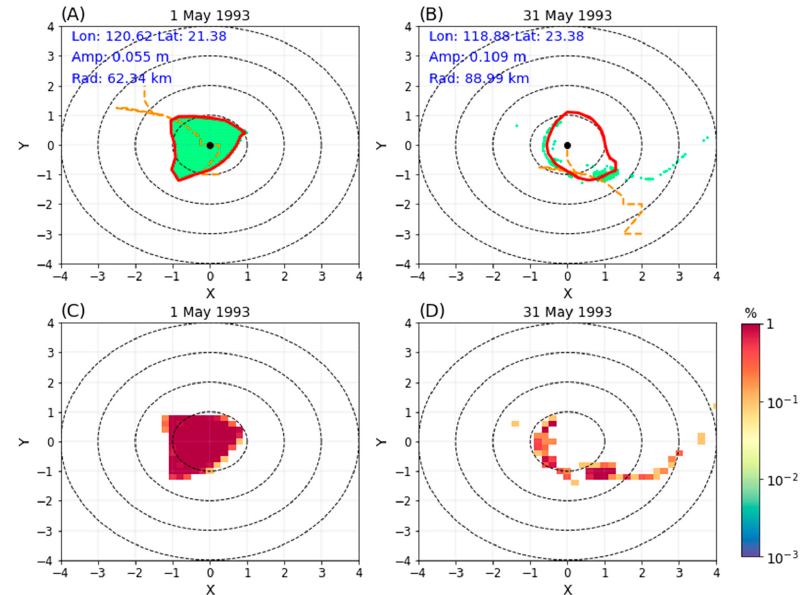
Figure 5. ( A , B ) Particle locations (green dots) and ( C , D ) distributions of Q in the normalized coordinate for a randomly-selected anticyclonic eddy at the initial and final times. Red contours represent SSH eddy boundaries. The eddy trajectory in the lifespan is denoted by the yellow dashed lines. Q is a measure of the proportion of initial eddy particles in each 0.2𝑅 × 0.2𝑅 grid.